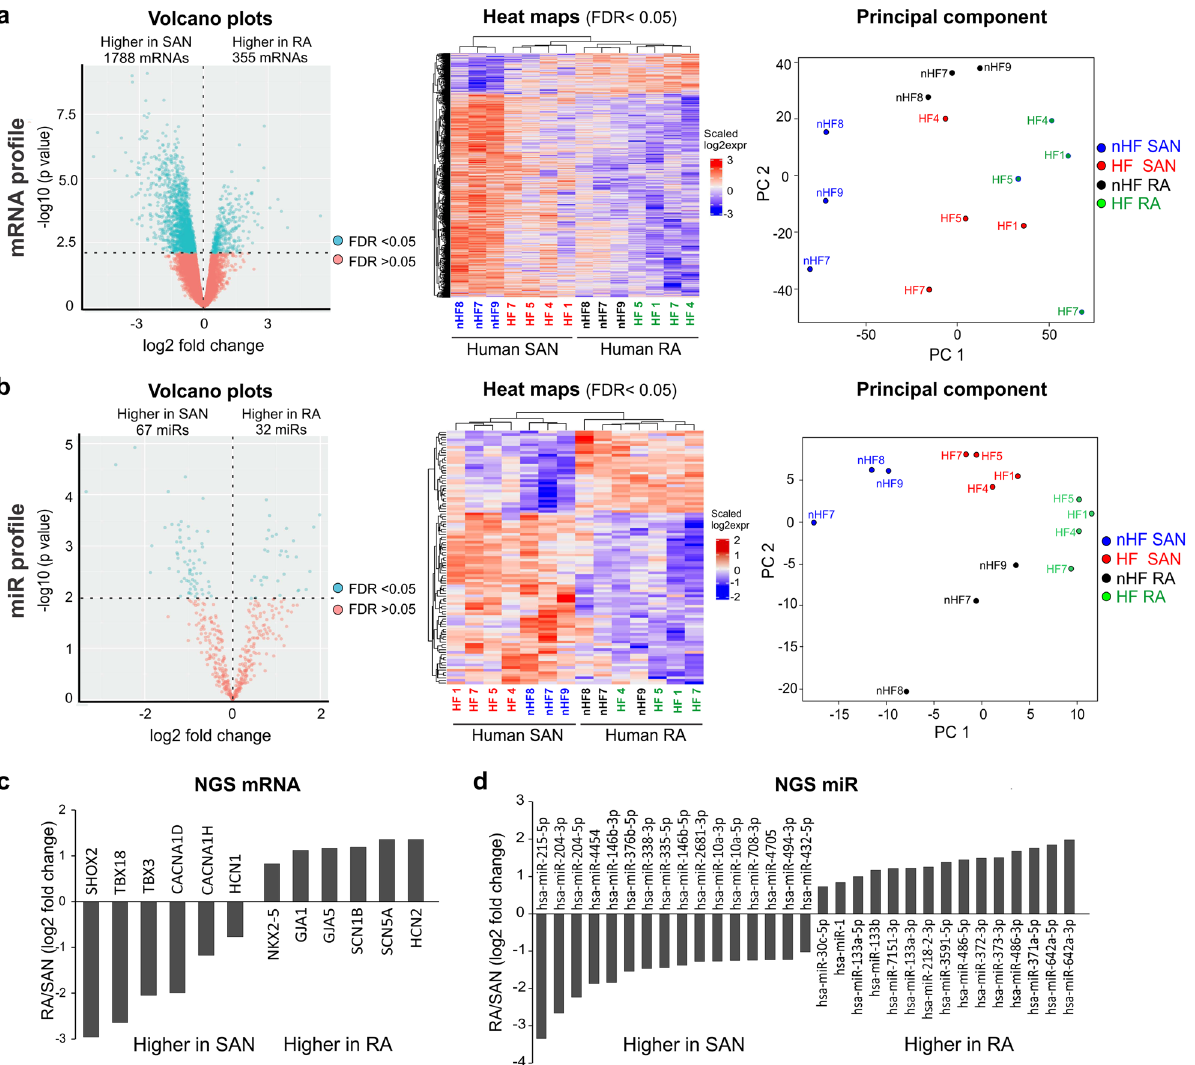
Figure 2. Comparison of miR and mRNA profiles of the human SAN vs RA. ( a ) Volcano plot (left) of mRNA profile for paired human SAN and RA (n = 7). Heat map (middle) of significantly different mRNAs for paired SAN and RA. PCA (right) for SAN and RA mRNA samples; each circle represents a single sample. ( b ) Volcano plot (left) of miR profile for paired human SAN and RA. Heat map (middle) of significantly different miRs for paired SAN and RA. PCA (right) for SAN and RA miR samples; each circle represents an individual sample. ( c ) Bar graphs show representative significantly different (FDR < 0.05) mRNAs and ( d ) miRs in the human SAN vs. RA detected by NGS. Plots and heat maps were generated with R 3.6.3. HF indicates heart failure; NGS, next generation sequencing; PCA, principal component analysis; qPCR, quantitative polymerase chain reaction; RA, right atrium; and SAN, sinoatrial